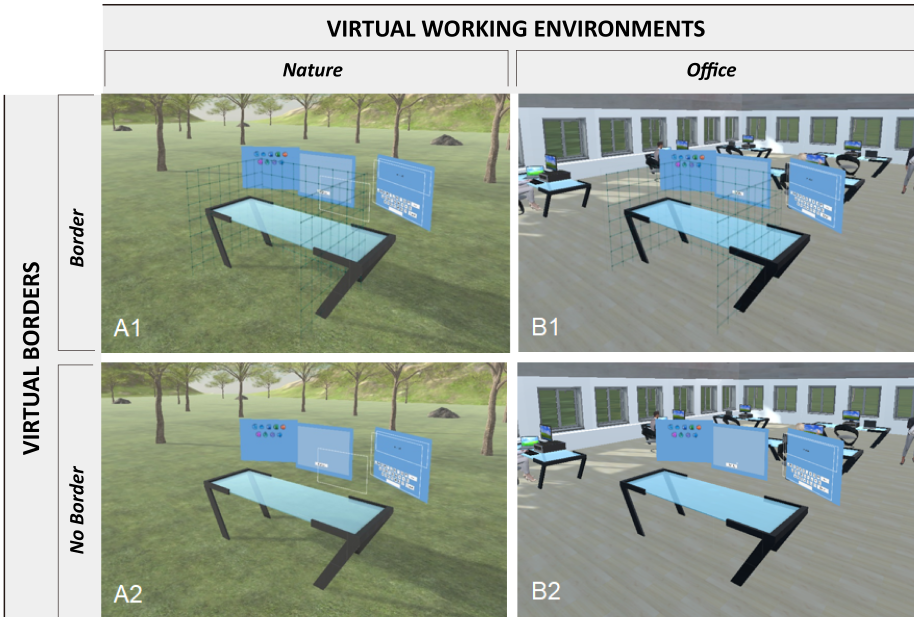
Figure 1. The study conditions differ in the type of virtual environment (A = Nature and B = Office) and the display of virtual borders (1 = Border and 2 = No Border). The grids visualise the physical boundaries of the rear-seat environment along the horizontal axis of the three virtual